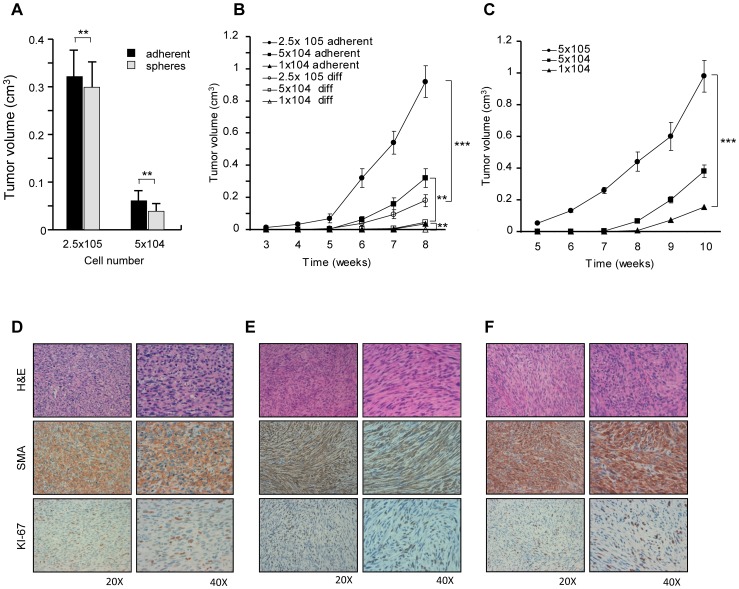
Undifferentiated LMS cells are highly tumorigenic and reproduce the human tumor in immunocompromised mice.A) Tumor volumes of xenografts generated by injection of spheres or adherent undifferentiated LMS cells (6 weeks post-injection). Mean ± SD of 3 independent experiments is shown. ** p<0,01. B) Tumor growth rate of undifferentiated (adherent) or differentiated (diff) LMS cells injected subcutaneously in NOD-SCID mice at the indicated cell doses. Mean ± SD of 3 independent experiments is shown. ** p<0,01, ***p<0,001. (C) Tumor growth rate of secondary tumors injected subcutaneously in NOD-SCID mice at the indicated cell doses. Mean ± SD of 3 independent experiments is shown. ***p<0,001. D) Hematoxylin and eosin (H&E) or immunohistochemistry for the indicated antigens performed on patient tumor (D), tumor generated by subcutaneous injection of LMS spheres (E) or adherent undifferentiated cells (F). The original magnification for each image is indicated.